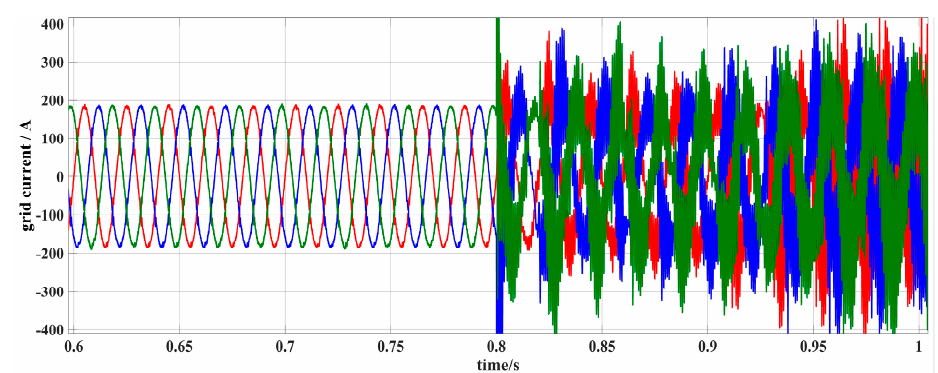
Figure 5. Simulated waveform of grid current under different conditions (parameters from Table 1).